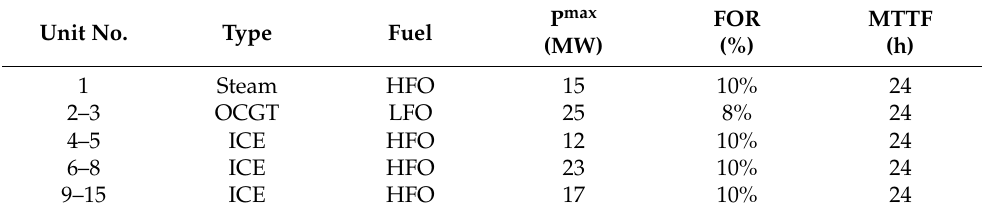
Table 1. Main characteristics of conventional units of the study case system 1 . Unit